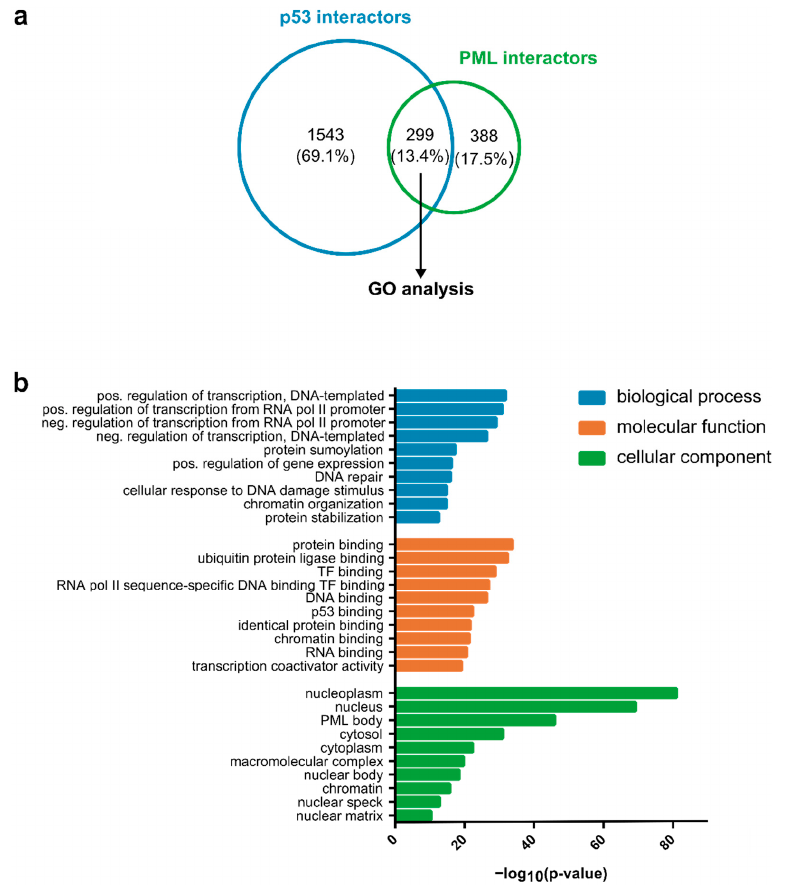
Figure 2. Identification of potential, functional protein interactions of p53 at PML biocondensates. ( a ) Overlap between PML- and p53-interacting human proteins. PML and p53 interactors were retrieved from the BioGRID database (June 2022). Of those interactors, 299 associate with both p53 and PML. A list of these proteins is given in the Table 1. ( b ) DAVID functional gene ontology (GO) enrichment analysis (June 2022) of the 299 proteins interacting with both p53 and PML. Different colors represent biological process, molecular function, and cellular component GO categories. The top 10 most significantly enriched GO terms for each category are plotted. DAVID, Database for Annotation, Visualization and Integrated Discovery; GO, gene ontology; neg., negative; pol, polymerase, pos., positive; TF, transcription